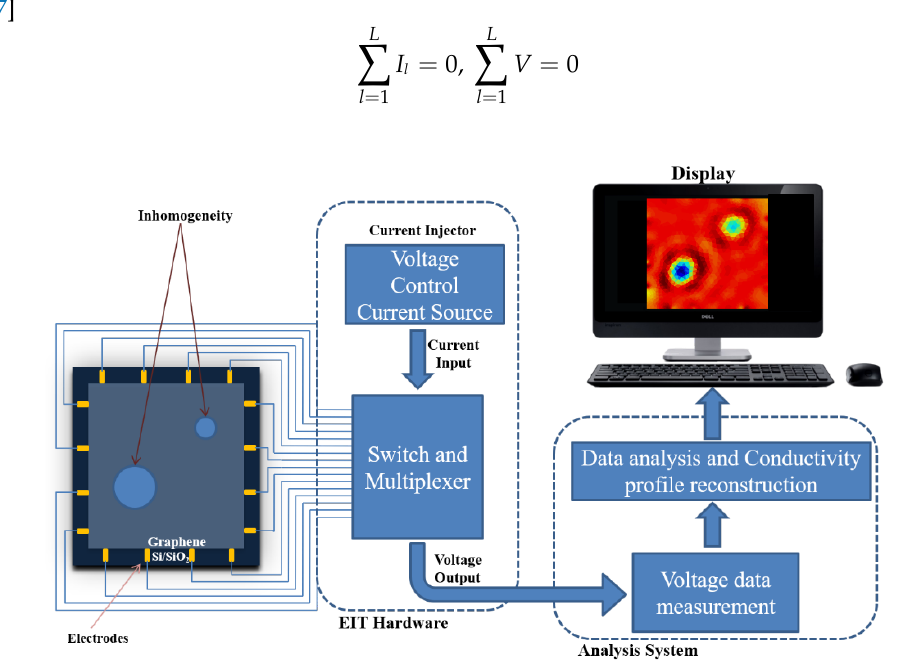
Figure 1. Diagram illustrating the application of electrical impedance tomography (EIT) to map the conductivity profile of monolayer graphene.